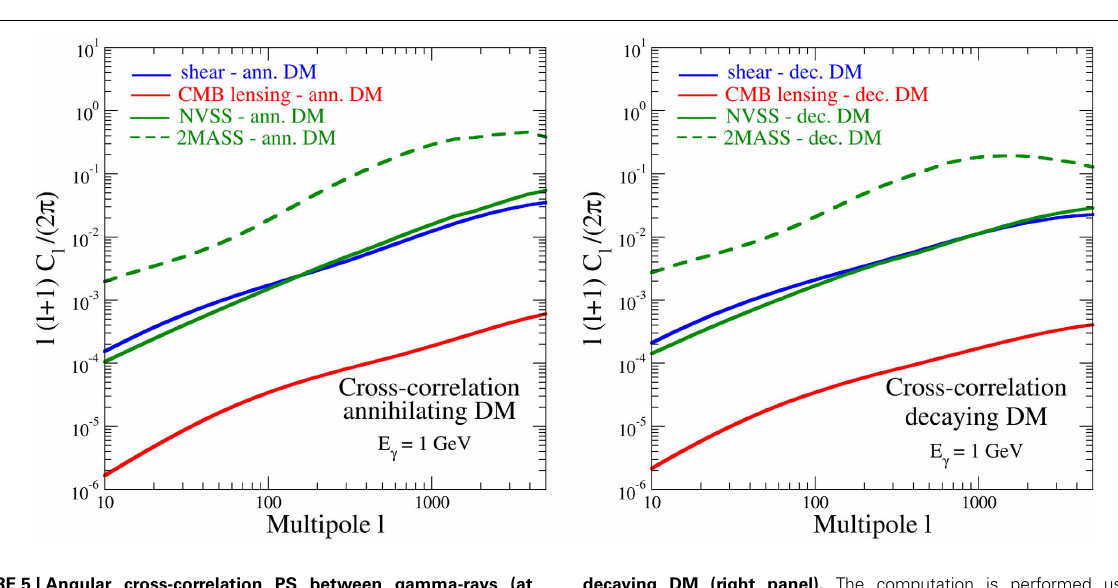
FIGURE 5 | Angular cross-correlation PS between gamma-rays (at E γ = 1 GeV) and gravitational tracers (cosmic shear, CMB lensing and LSS tracers), for annihilating DM (left panel) and